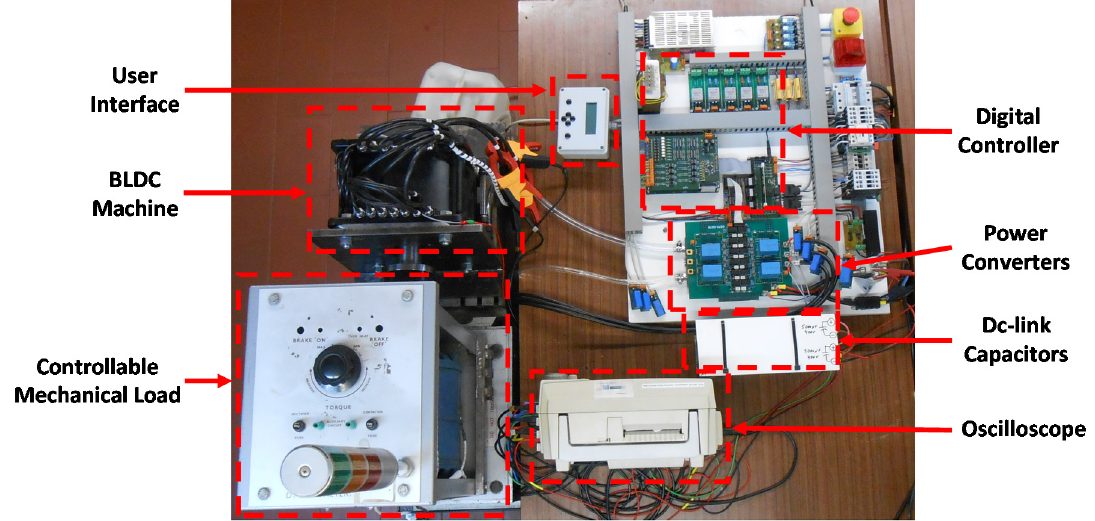
Figure 26. Experimental setup of the developed laboratorial prototype of the proposed unified power converter.